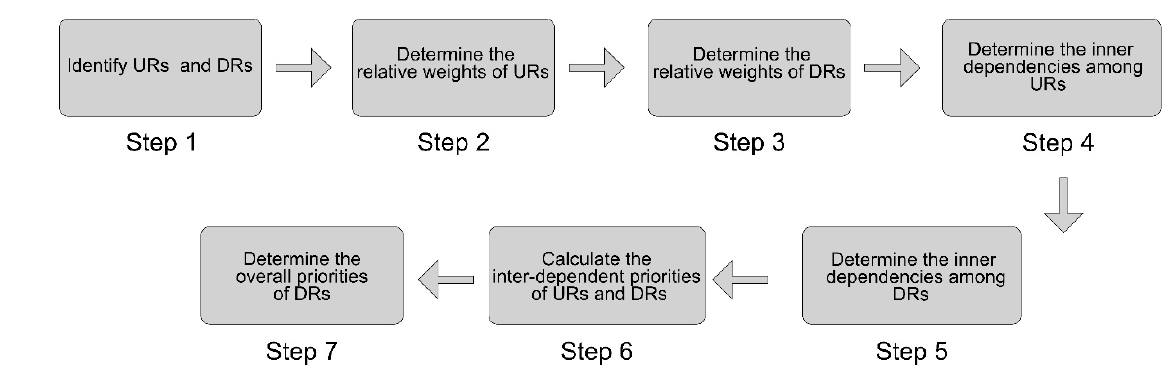
Figure 3. Research steps.